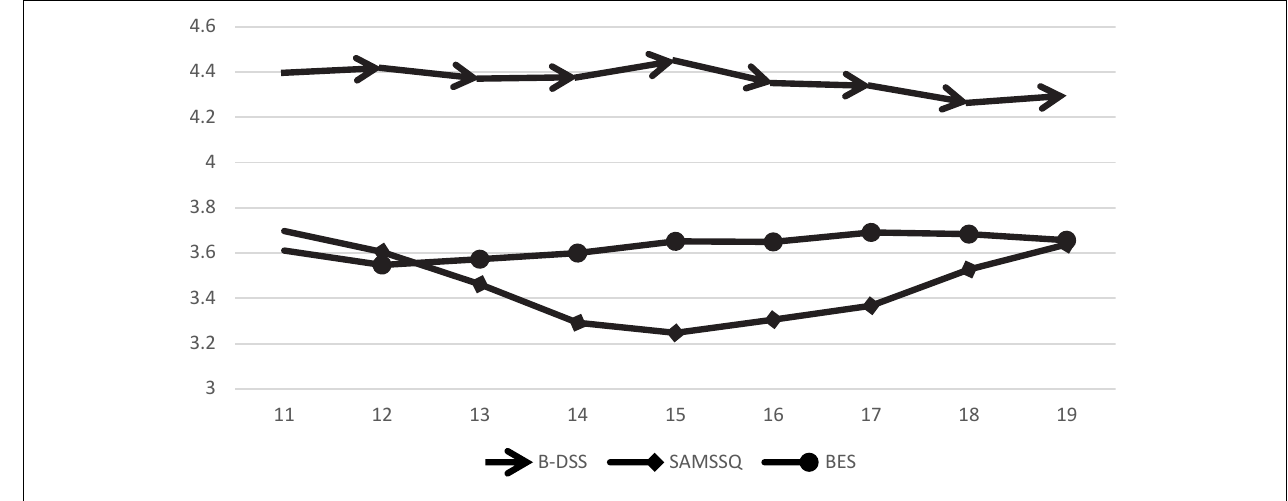
FIGURE 1 | Trend chart of the scores for the three abilities along with